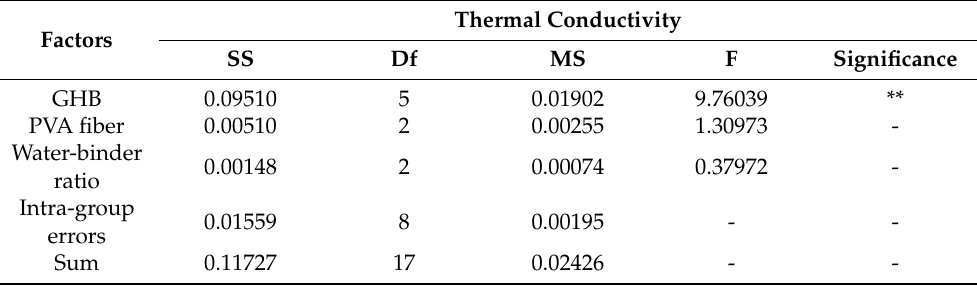
Table 8. Variance analysis results of thermal